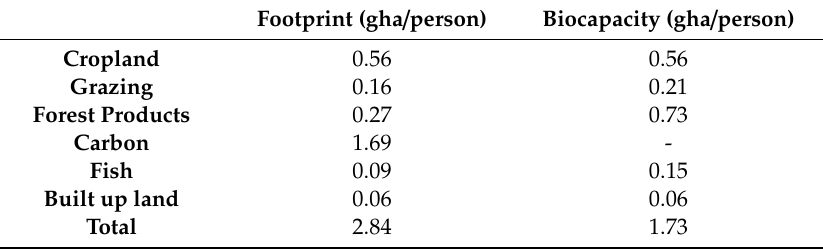
Table 1. Global average ecological footprint, from the Global Footprint Network’s 2016 National Footprint and Biocapacity Accounts